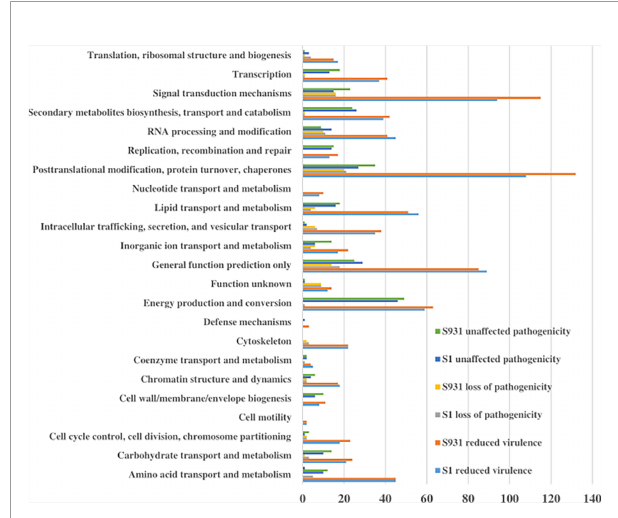
FIGURE 4 | The KOG functional categories for “ reduced virulence, ” “ unaffected pathogenicity, ” and “ loss of pathogenicity ” in S1 and